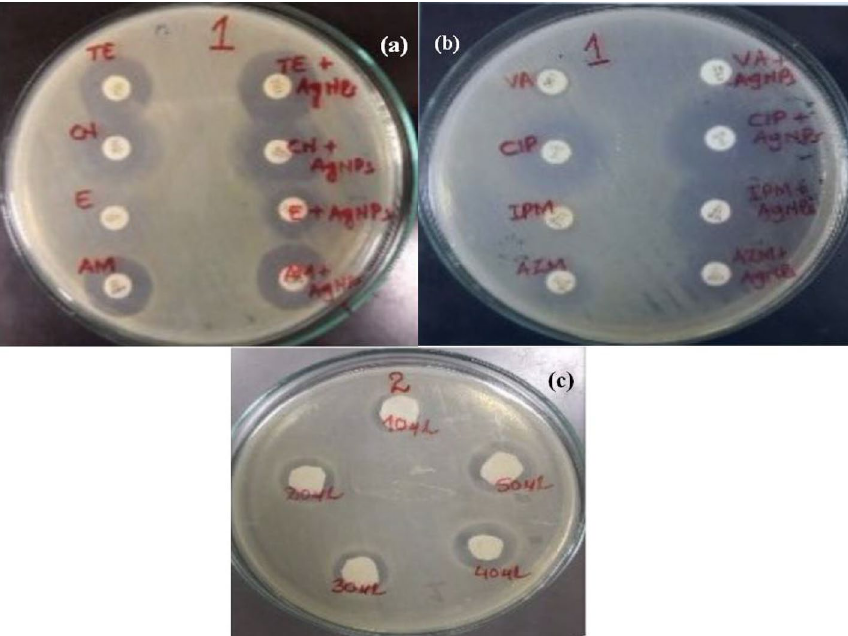
Figure 8. Antimicrobial effects: ( a , b ) AgNPs and antibiotic-AgNPs combinations, ( c ) AgNPs activity at varying